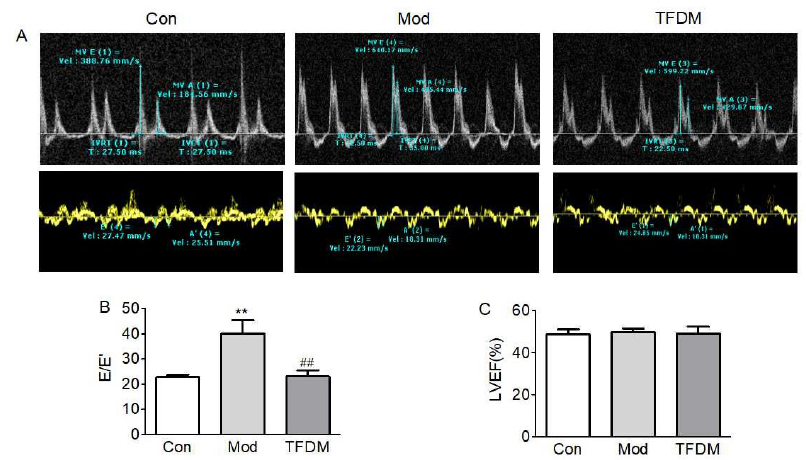
Figure 8. Effects of TFDM on cardiac function. ( A ) Representative images of pulsed-wave and tissue Doppler recording through the left ventricle. ( B ) Ratio between mitral E wave and E’ wave (E/E’). ( C ) Percentage left ventricular ejection fraction (LVEF%) ( n = 6); compared with Con group: ** p < 0.01; compared with Mod group ## p < 0.01.